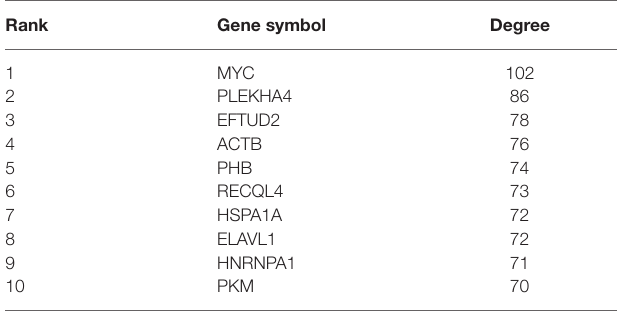
TABLE 1 | The top 10 interacted genes in the network according to degree analyzed in Metascape. Rank Gene symbol Degree